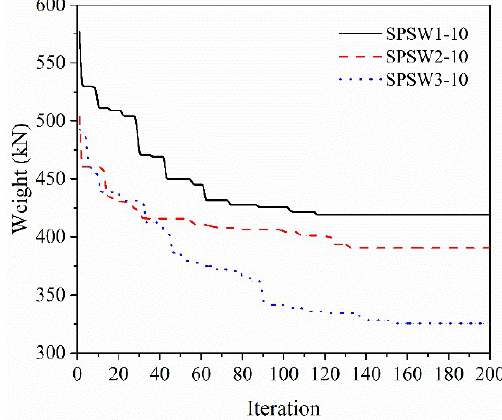
Figure 12. Convergence histories of 10-story steel frame.